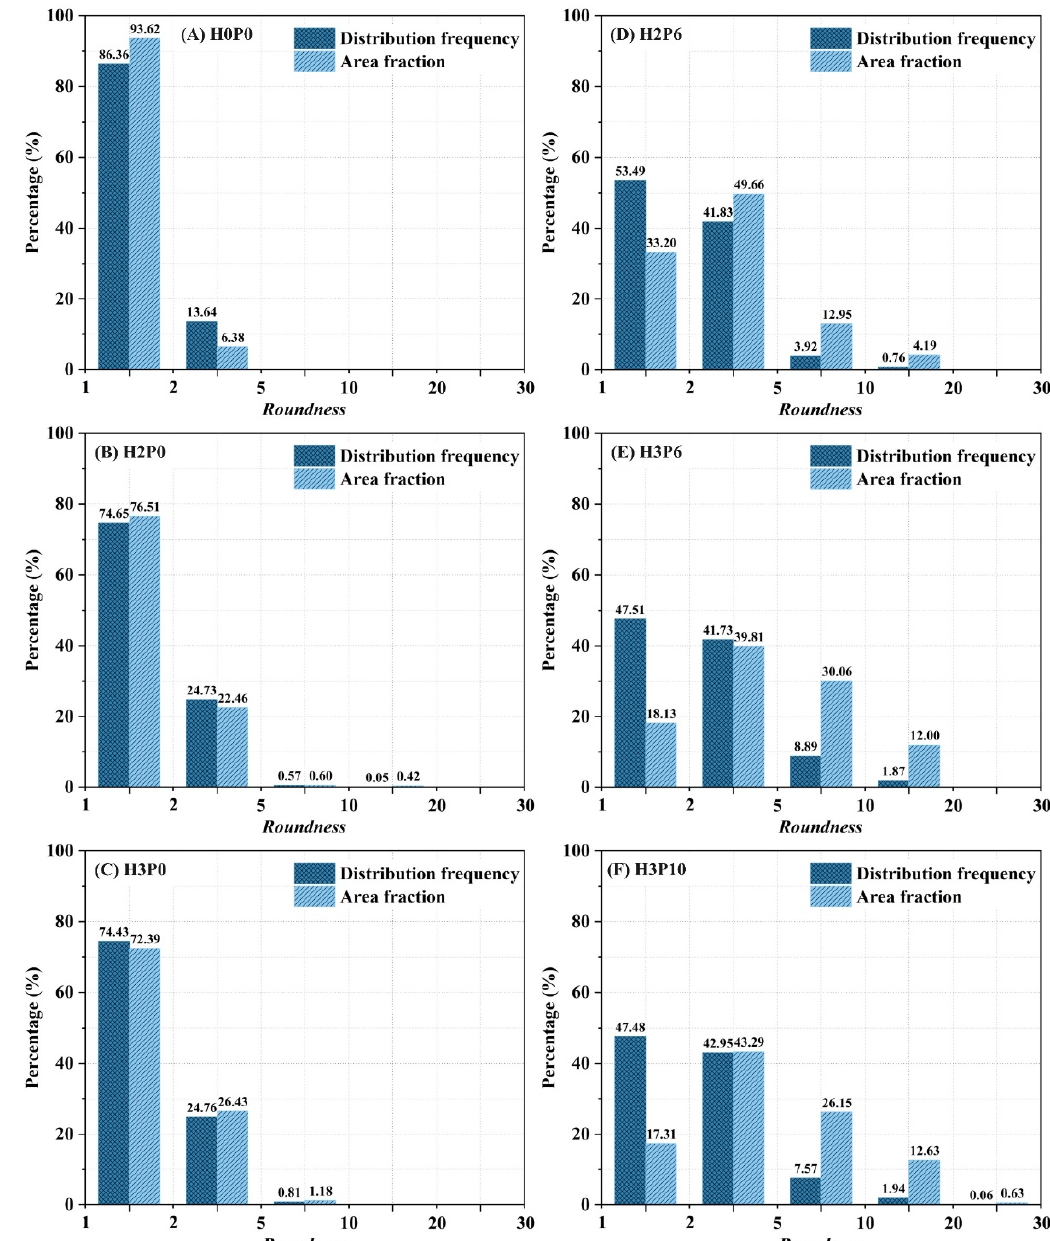
Figure 14. Pore distribution frequency and area fraction of geopolymer foams: ( A ) H0P0, ( B ) H2P0,